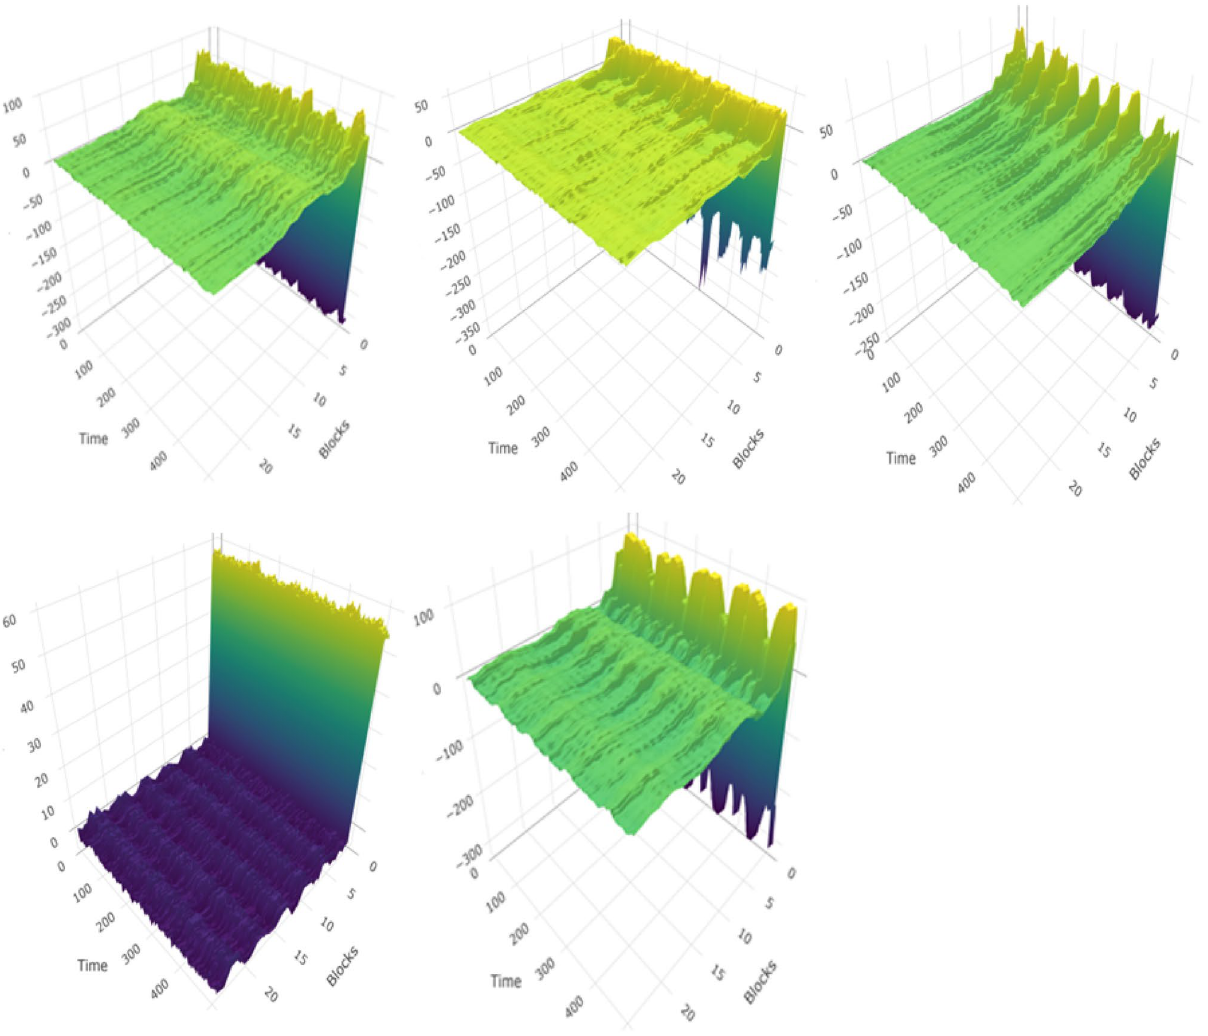
Figure 2. The patterns of SDC-L by the diagnostic condition : Healthy, URTI, COPD on the first row, and Pneumonia and Bronchiolitis on the second